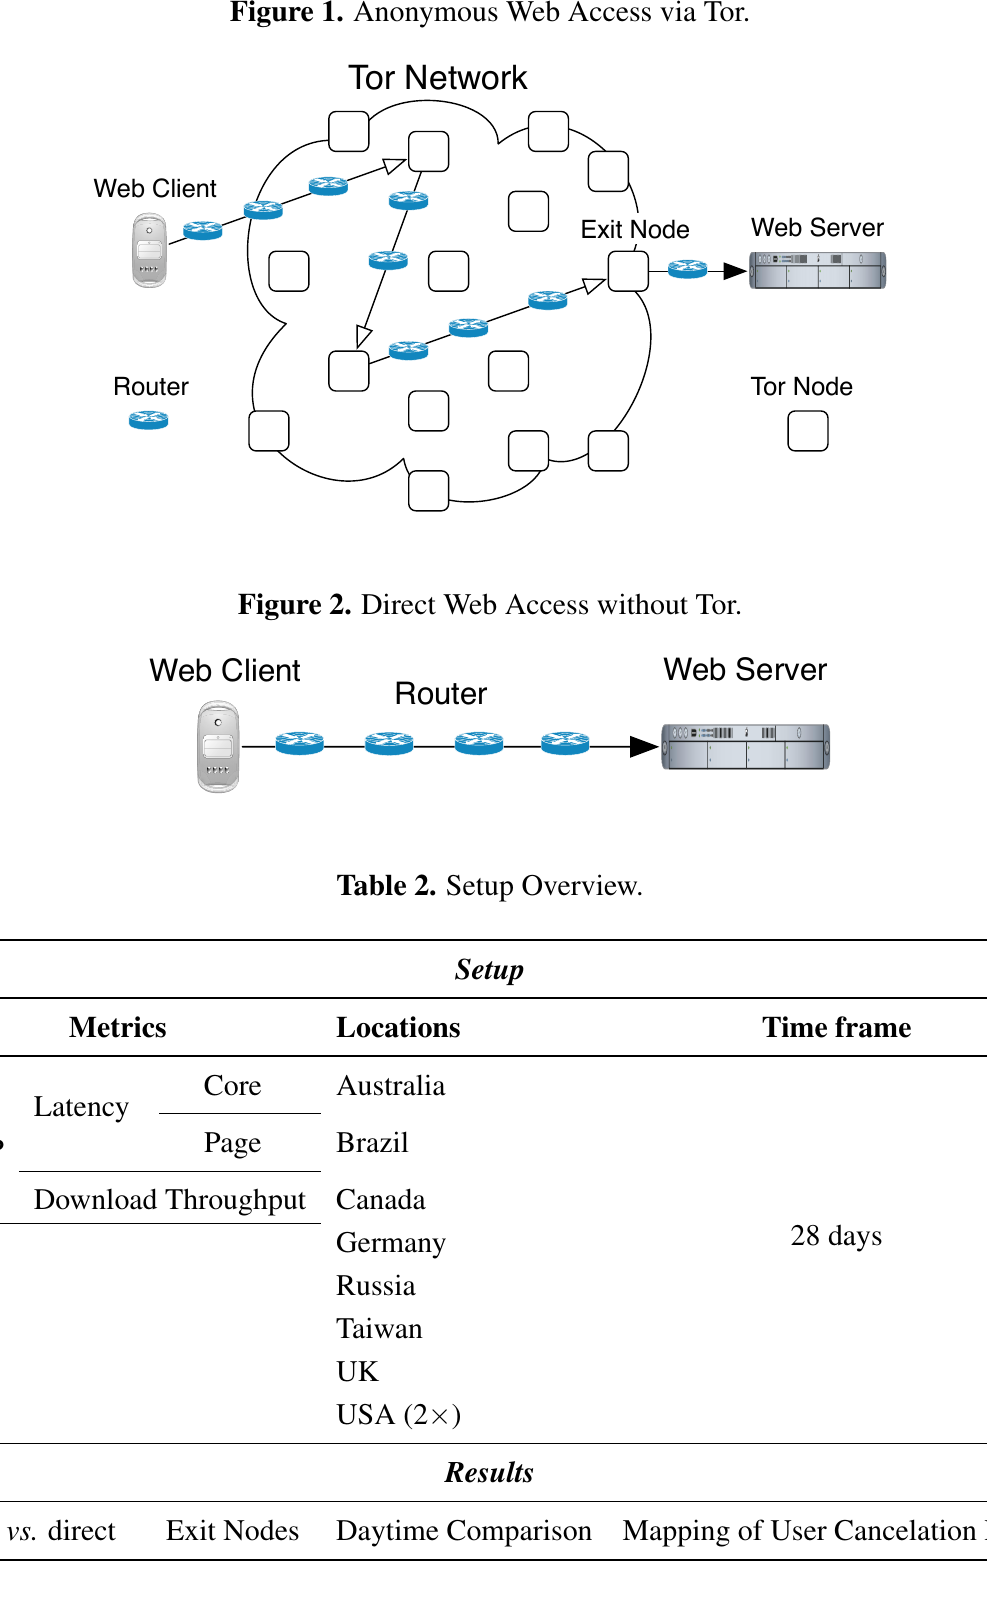
Figure 1. Anonymous Web Access via Tor.